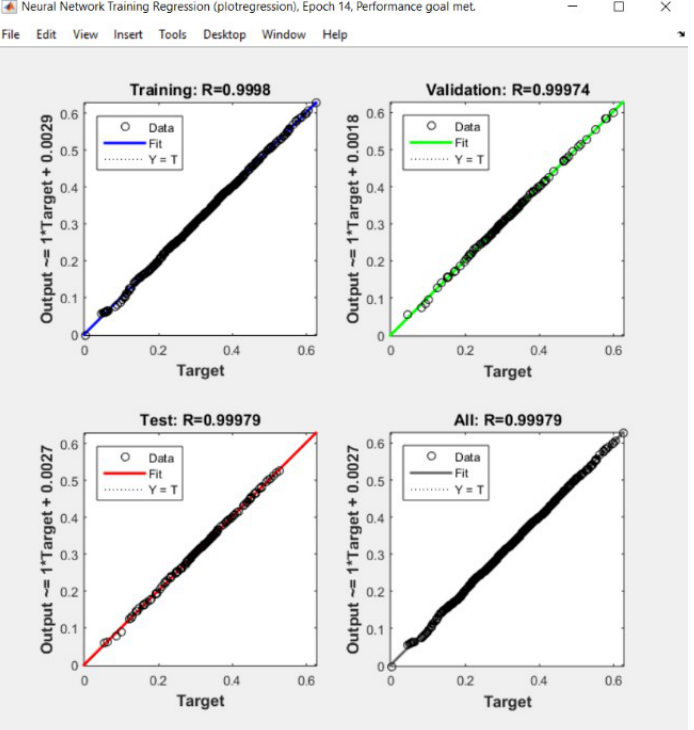
Figure 7. Correlation coefficients for training, testing and validation data sets, as well as for the whole data